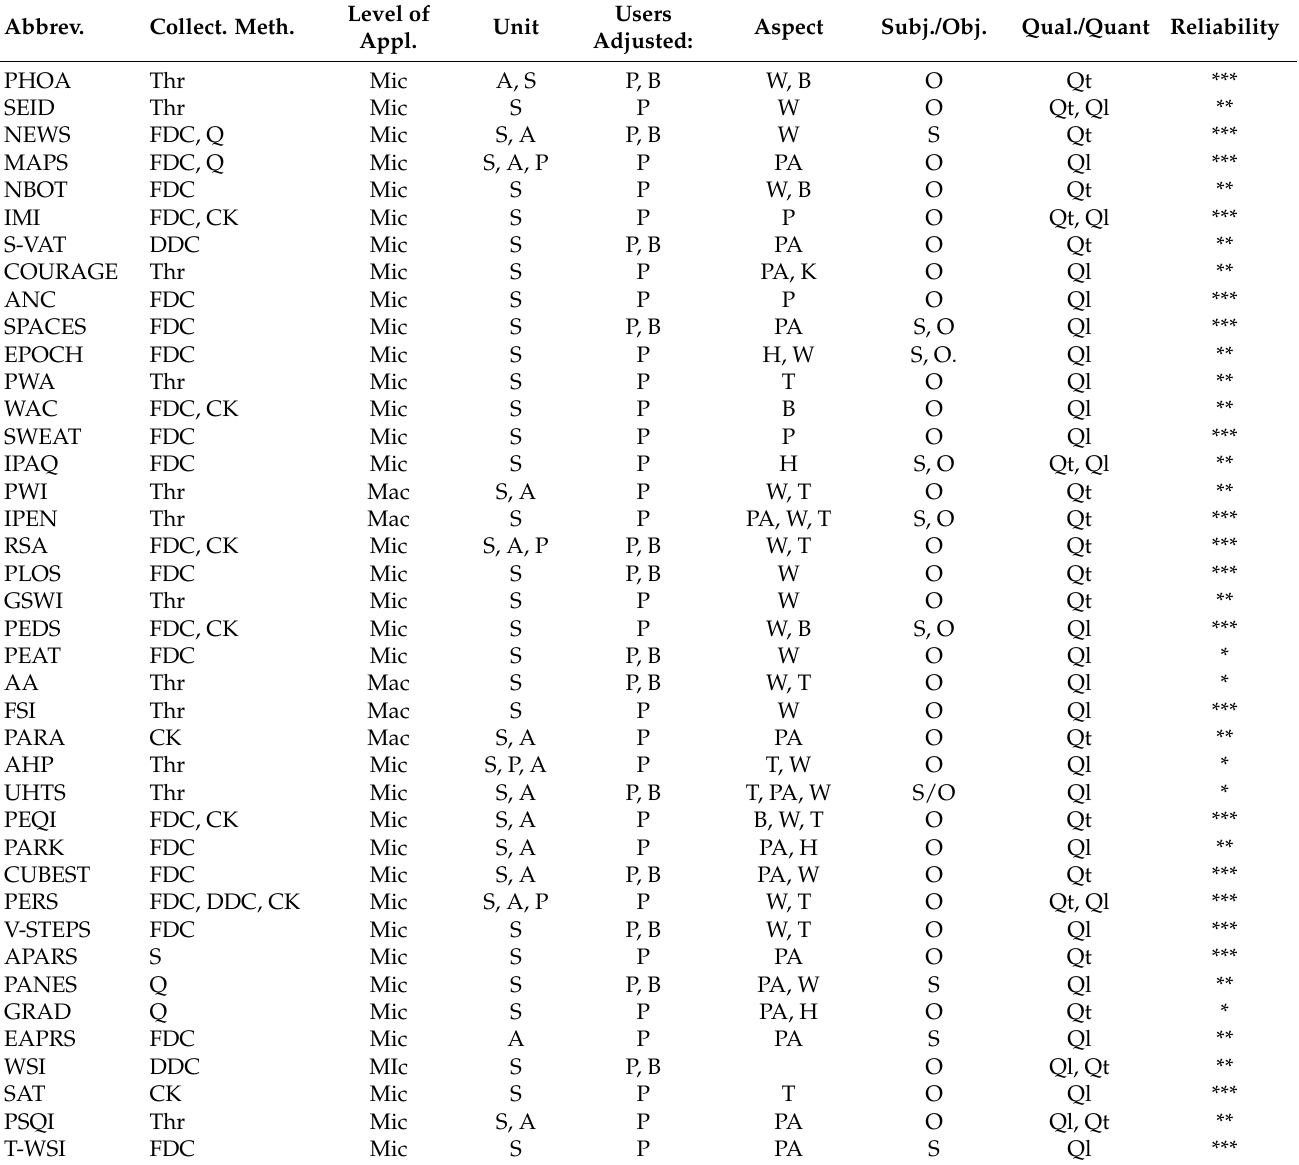
Table 2. List of relevant methodologies/instruments selected for the analysis—in